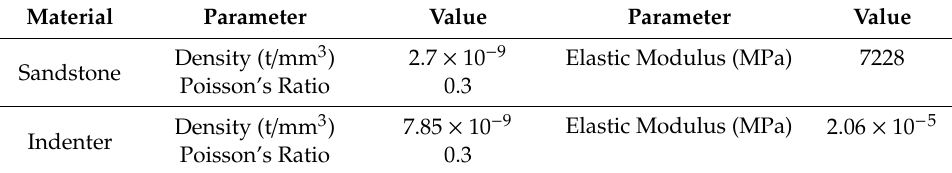
Table 2. Property parameters of the rock and the indenter in the simulation.